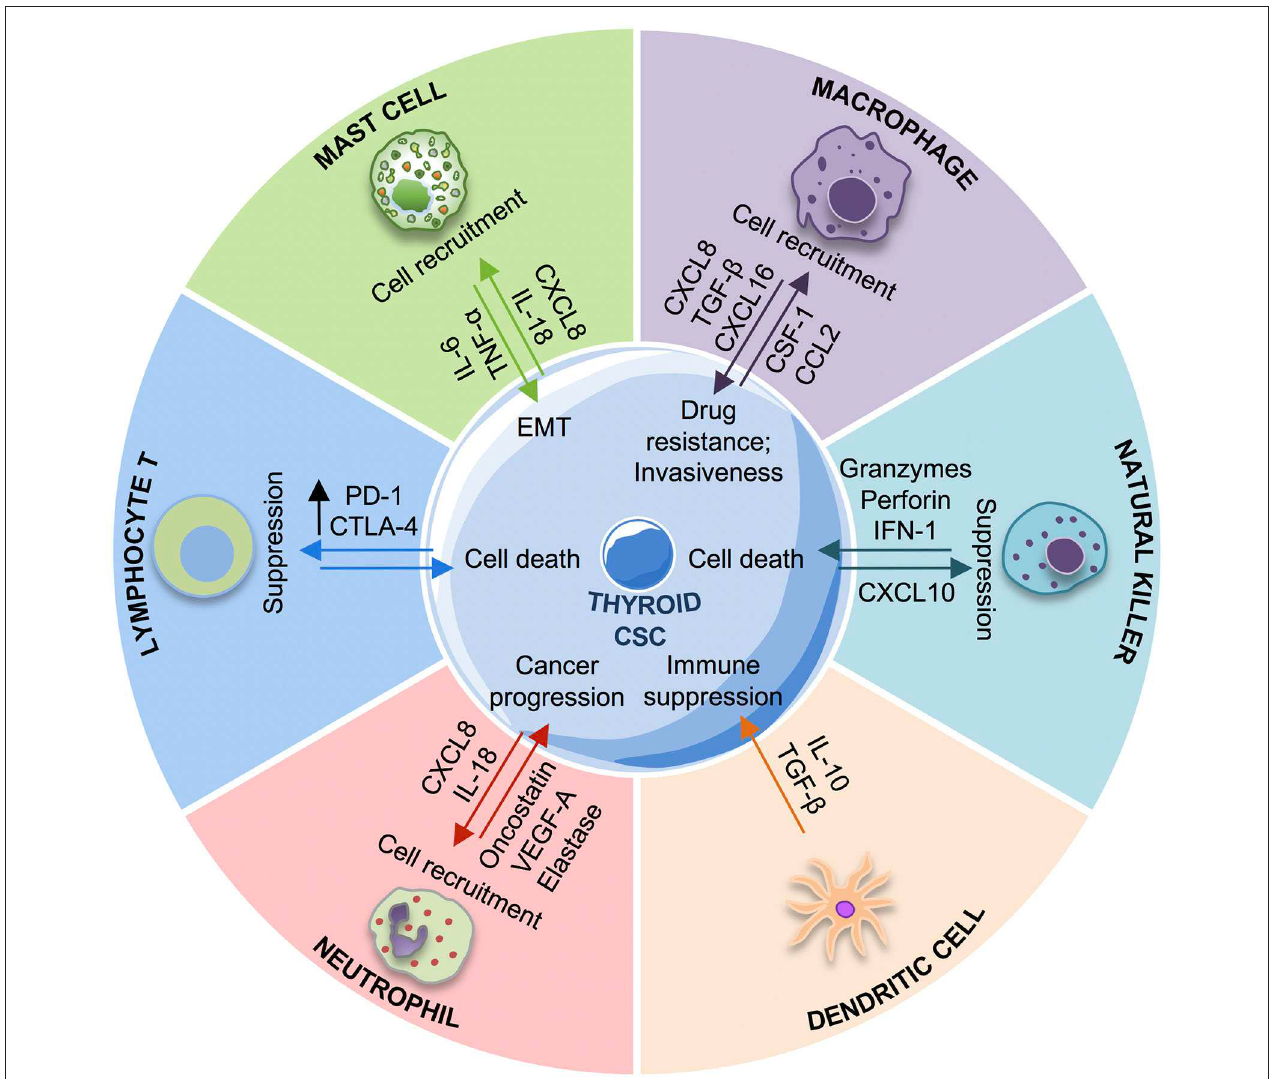
FIGURE 3 | Cross-talk between immune system and thyroid cancer stem cells (TCSCs). The schematic picture describes the interactions between TCSCs and different innate and adaptive immune cells. TCSCs escape from immune response by different mechanisms: recruiting macrophages M2, mast cells, neutrophils with protumorigenic roles promoting the immunosuppressive response through the release of interleukin (IL)-10 by MDSCs and iDCs, suppressing the NK cells response by PGE2, and upregulating CTLA-4 and PD-1. Conversely, the immune response contrasts the TCSC growth and proliferation by CD8 + T lymphocyte and NK cells cytotoxic activity. EMT, epithelial-to-mesenchymal transition; iDC, immature dendritic cells; IL-6, interleukin-6; IL-10, interleukin-10; CXCL-8, C–X–C motif chemokine ligand-8; CXCL16, C–X–C motif chemokine ligand 16; TGF- β , tumor growth factor- β ; VEGF-A, vascular endothelial growth factor A; TNF- α , tumor necrosis factor- α ; PGE2, prostaglandin-E2; CXCR3, CXC chemokine receptor; CCL-2, C–C motif chemokine ligand-2; csf-1, colony stimulating factor-1; NK cells, natural killer